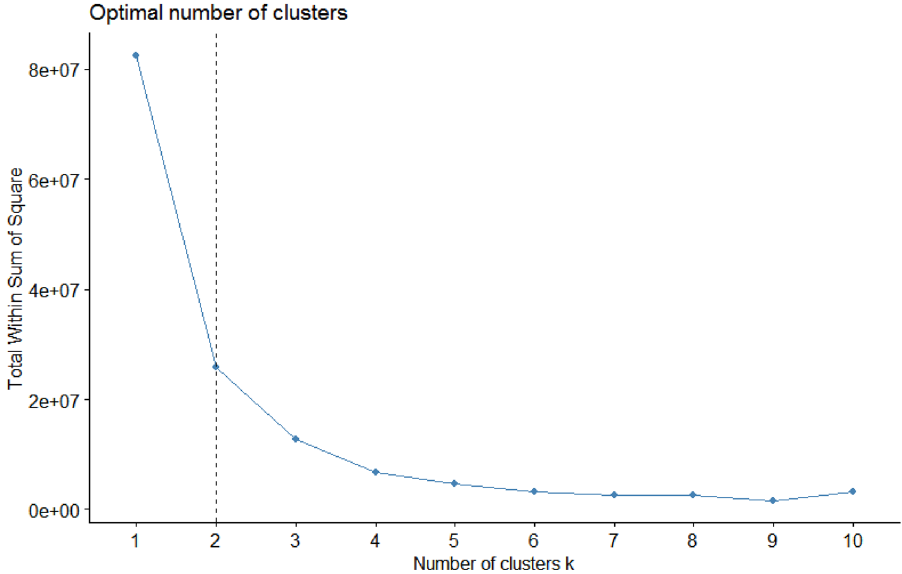
Figure 1. Identification of the elbow point for the evaluated